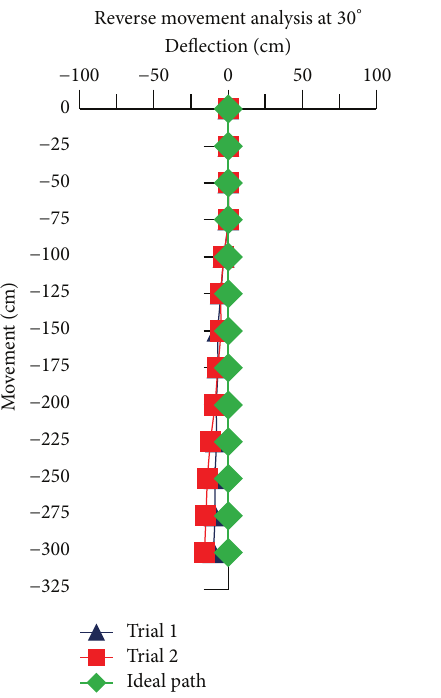
Figure 17: Reverse movement versus deflections at 𝜃 = 30 ∘ .